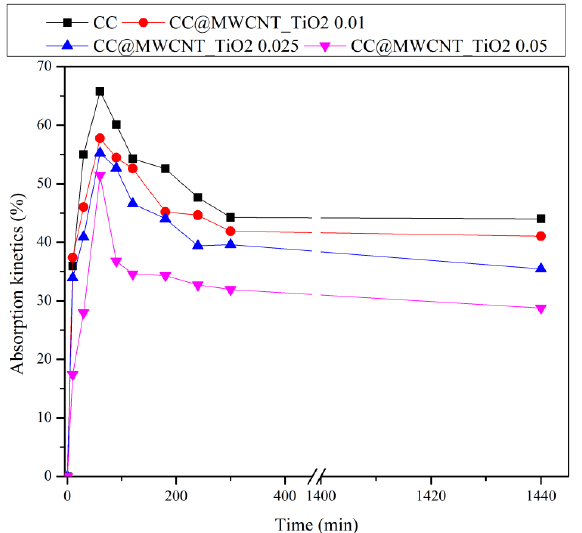
Figure 7. Absorption kinetics of the obtained